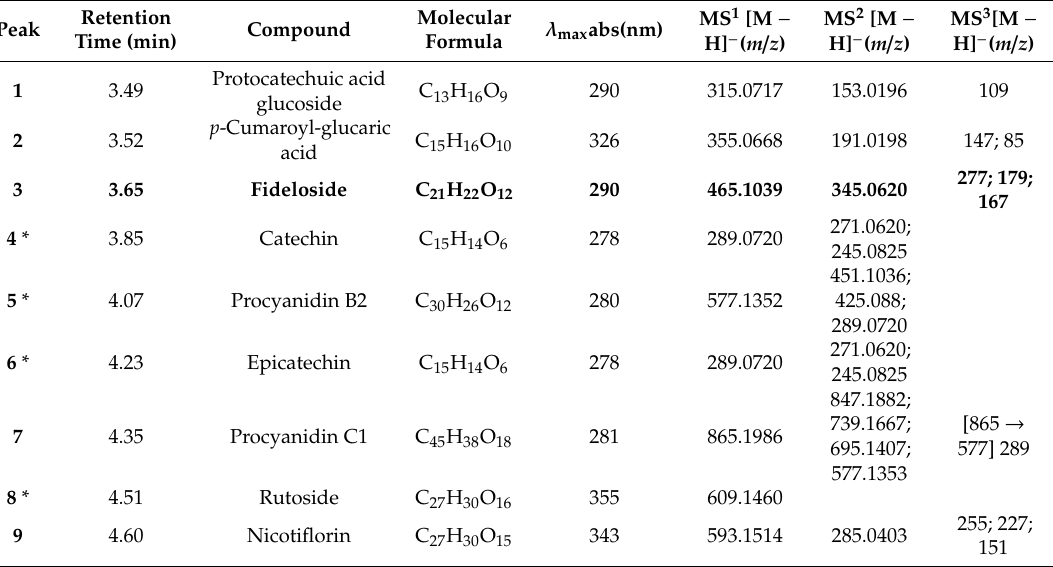
Table 1. Spectroscopic and spectrometric data of identified